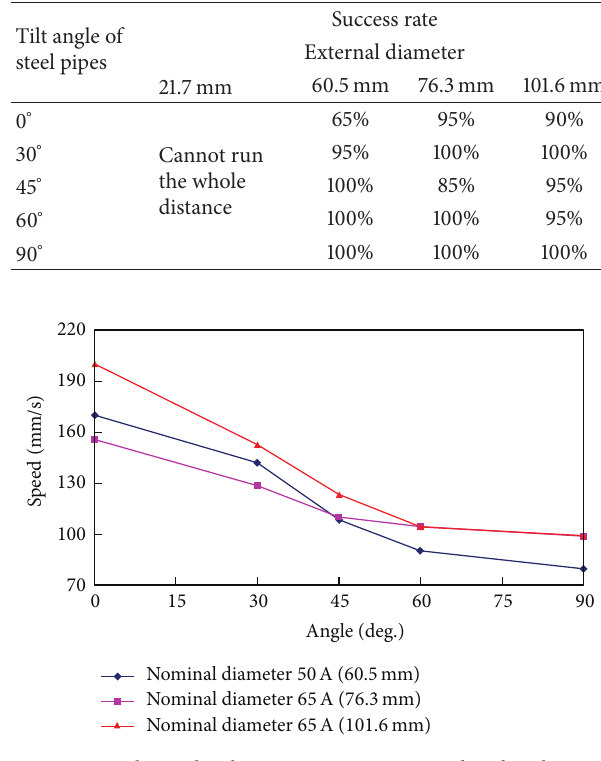
Figure 11: Relationship between movement speed and inclination angle of steel